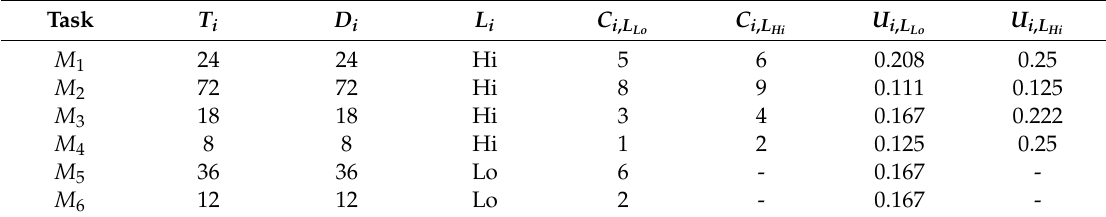
Table 5. Six-task set example.